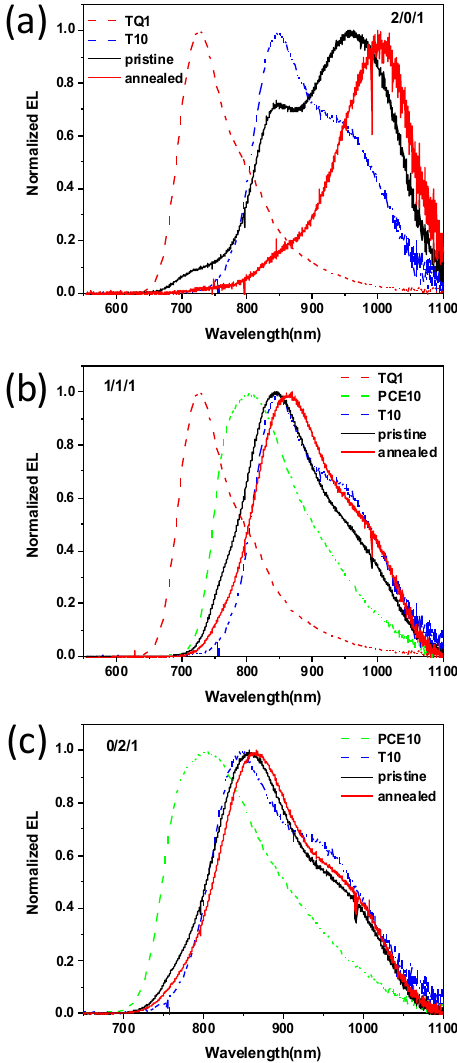
Figure 3. Electroluminescent ( EL) spectra of TQ1/PCE10/PNDI-T10 blend films with different blend ratio: ( a ) 2/0/1, ( b )1/1/1, and ( c ) 0/2/1.